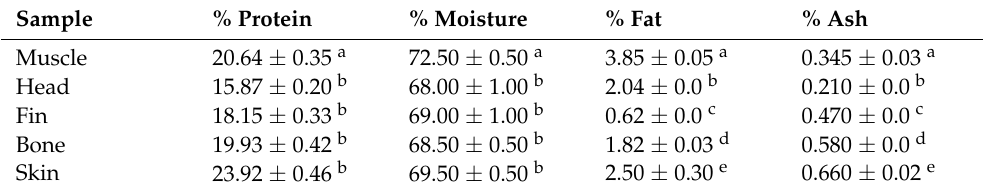
Table 1. Composition of catfish samples. Within columns, values with different letter superscripts are significantly